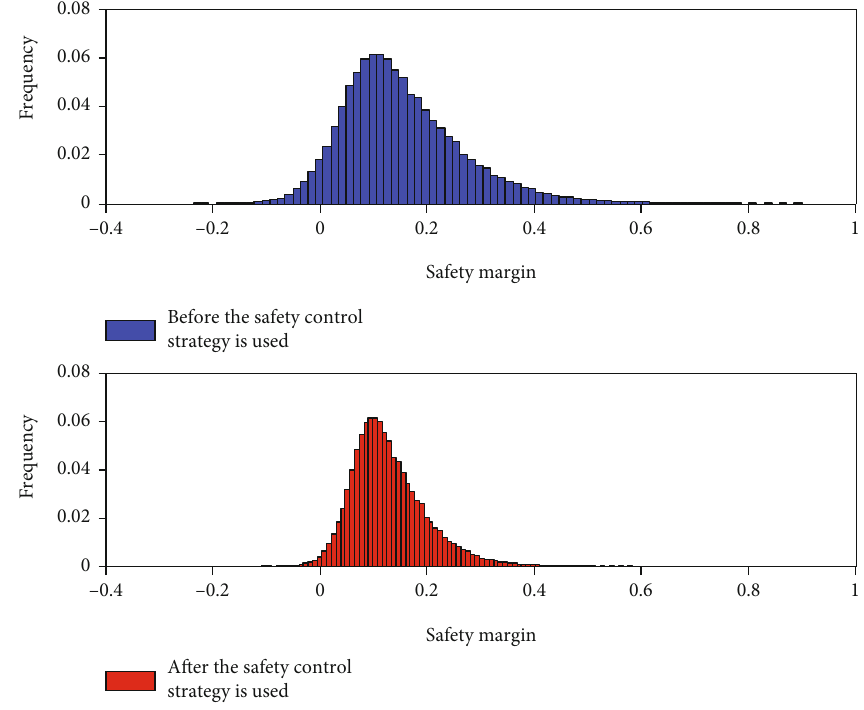
Figure 21: Probability distribution of the safety margin for the maximum explosion pressure Y